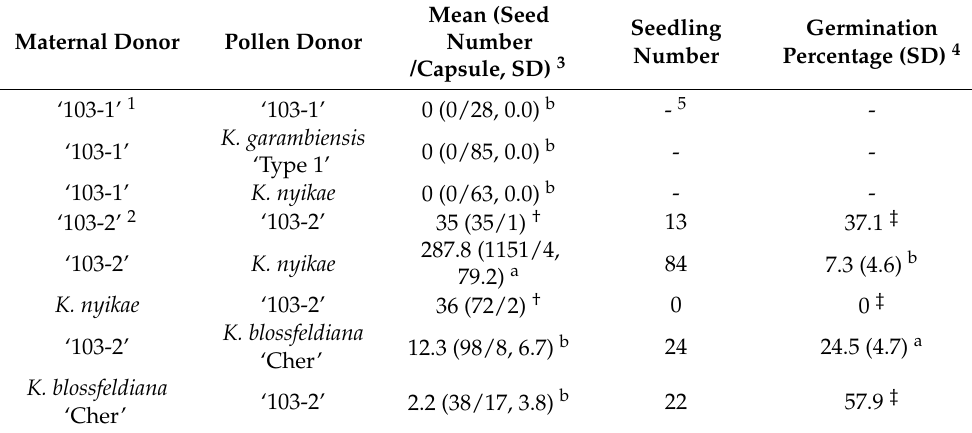
Table 2. Selfing and backcrossing are not sufficient to rescue the sterility of F 1 from interspecific crosses of K. garambiensis ‘Type 1’ × K. nyikae .